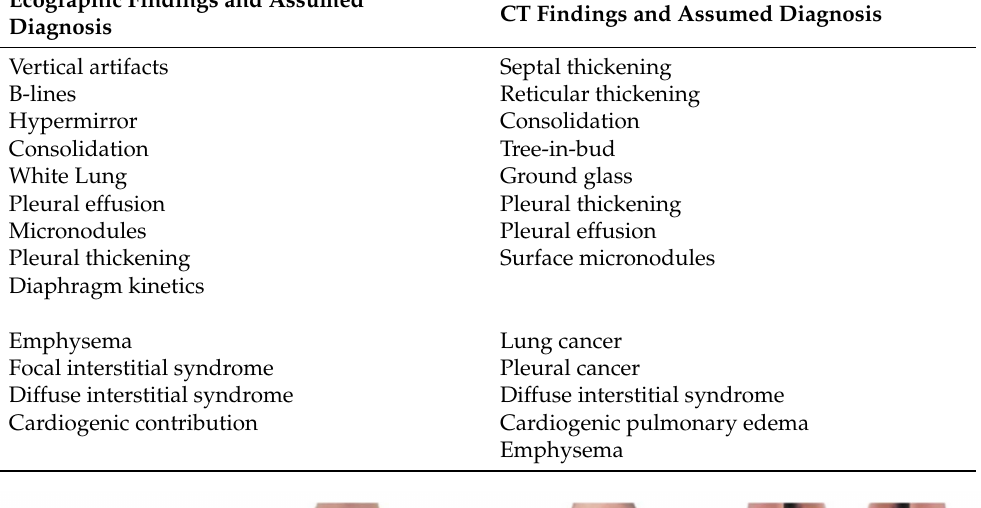
Table 1. Observed/registered findings and possible generic diagnoses expected with the ultrasound and CT examination.